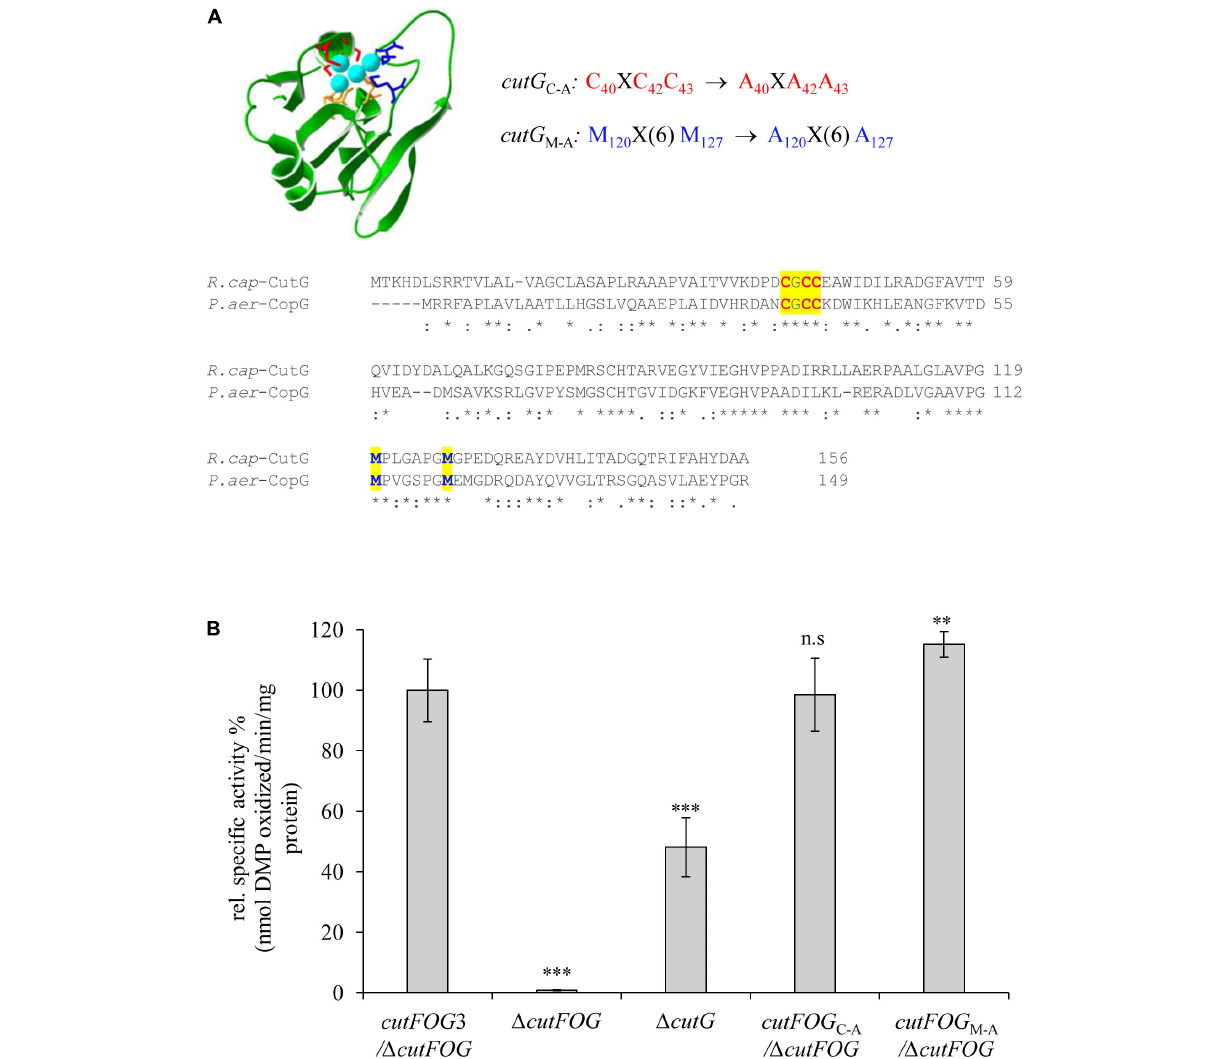
FIGURE 6 | CutG is not essential for CutO activity (A) Model for the R. capsulatus CutG built on the X-ray structure of CopG from Pseudomonas aeruginosa (PDB ID: 6WIS) by the Swiss-Model software. The upper panel shows the conserved motifs and their substitutions. The lower panel shows the amino acid alignment between the R. capsulatus ( R. cap ) CutG and P. aeruginosa ( P. aer ) CopG. The conserved Cysteines and Methionines are highlighted in red and blue letters, respectively. (B) CutO activities of the indicated strains expressing cutG C − A and cutG M − A . The periplasmic fractions were isolated from the strains grown on MPYE medium in the presence of 10 µ M CuSO 4 . 50 µ g total protein was used in the 2,6-DMP assay. The activity of the (cid:49) cutFOG strain carrying the plasmid pRK- cutFOG3 ( cutF N − Flag O Flag G MycHis ) strain was set to 100% and the relative activities of the other strains were calculated. Three independent experiments were performed with three technical repetitions and the error bars reflect the standard deviation ( n = 9). Statistical analyses were performed as in Figure 1 , using the activity of the cutFOG3 / (cid:49) cutFOG strain as reference. ( ∗ ) refers to p - values ≤ 0.05; ( ∗∗ ) to p -values ≤ 0.01, and ( ∗∗∗ ) to p -values ≤